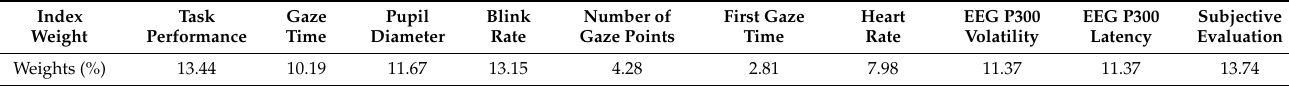
Table 12. Weights of evaluation